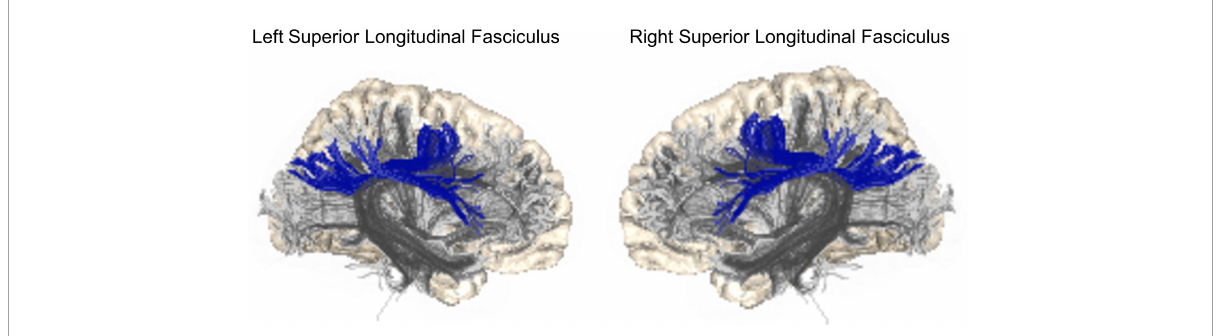
FIGURE1 Location of the left and right superior longitudinal fasciculus showing in the